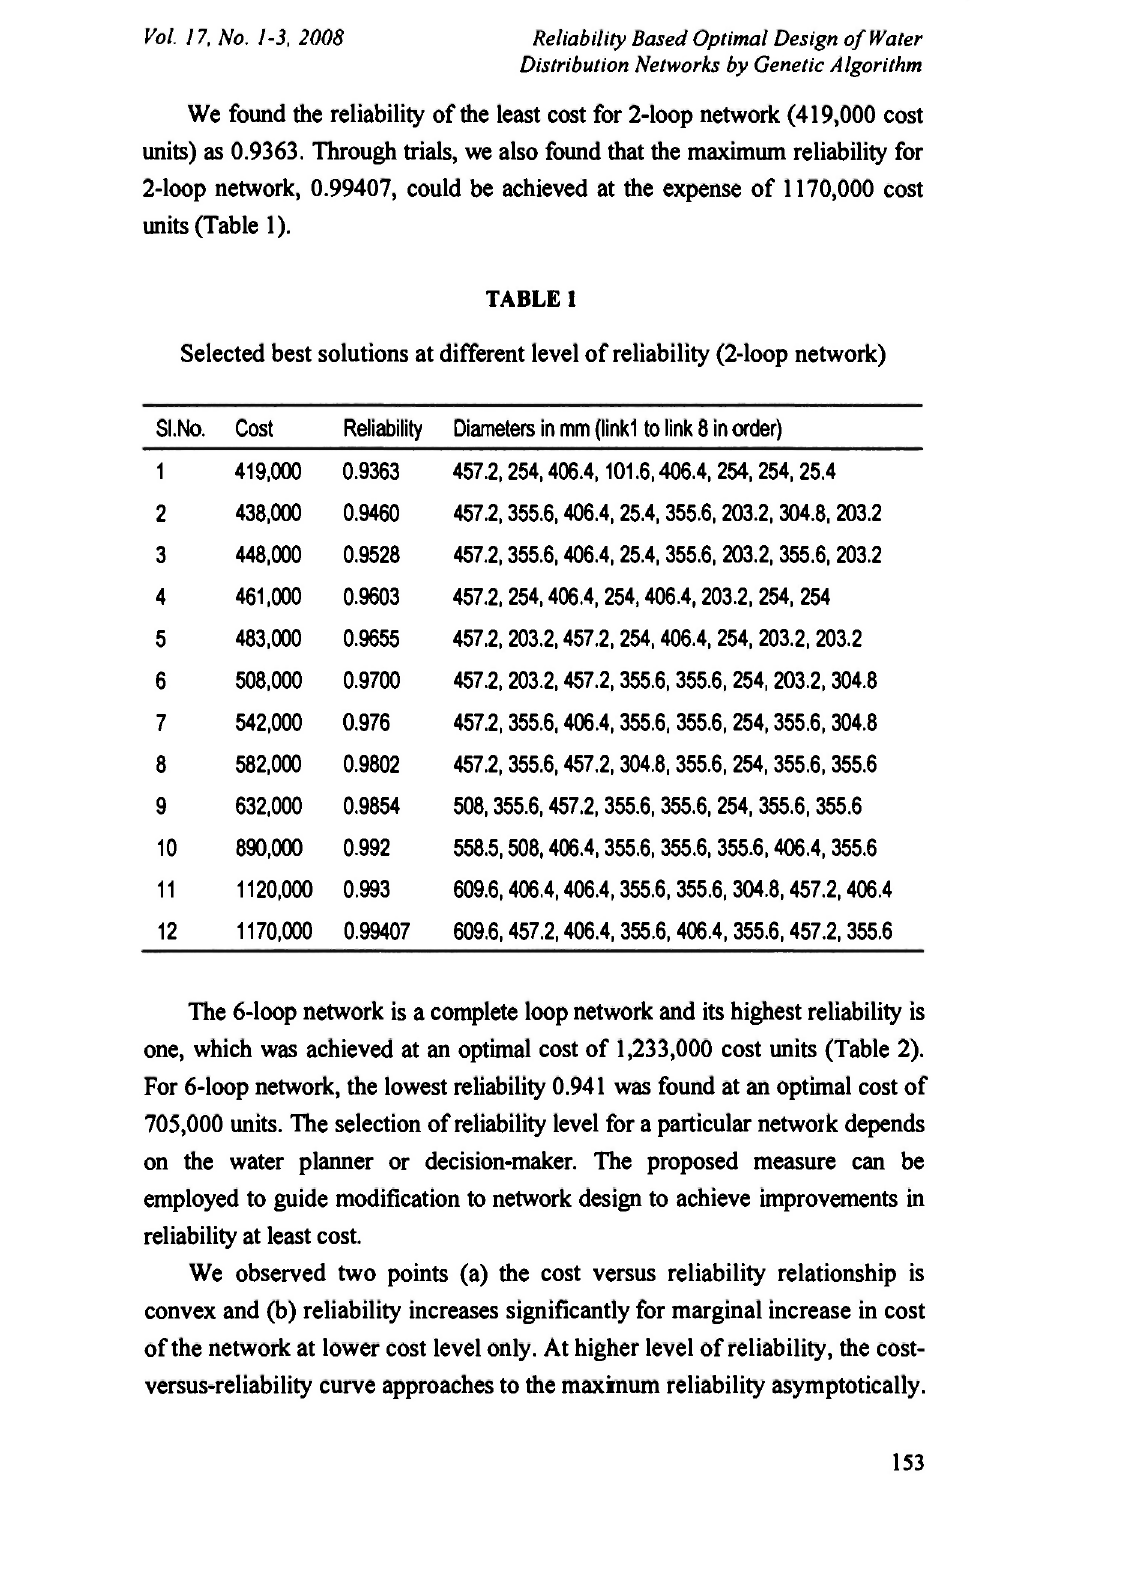
Selected best solutions at different level of reliability (2-loop network)